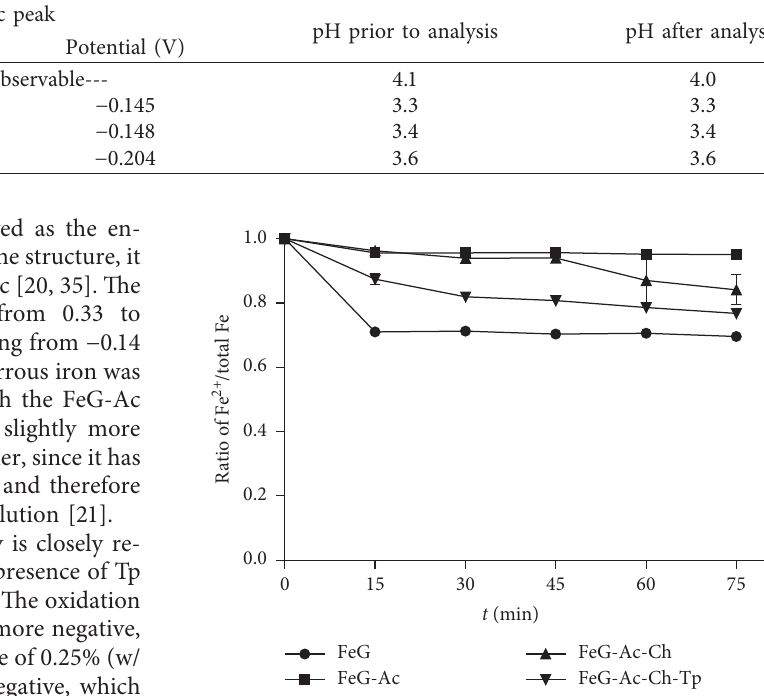
Figure 6: The oxidation rate of soluble ferrous iron in a batch